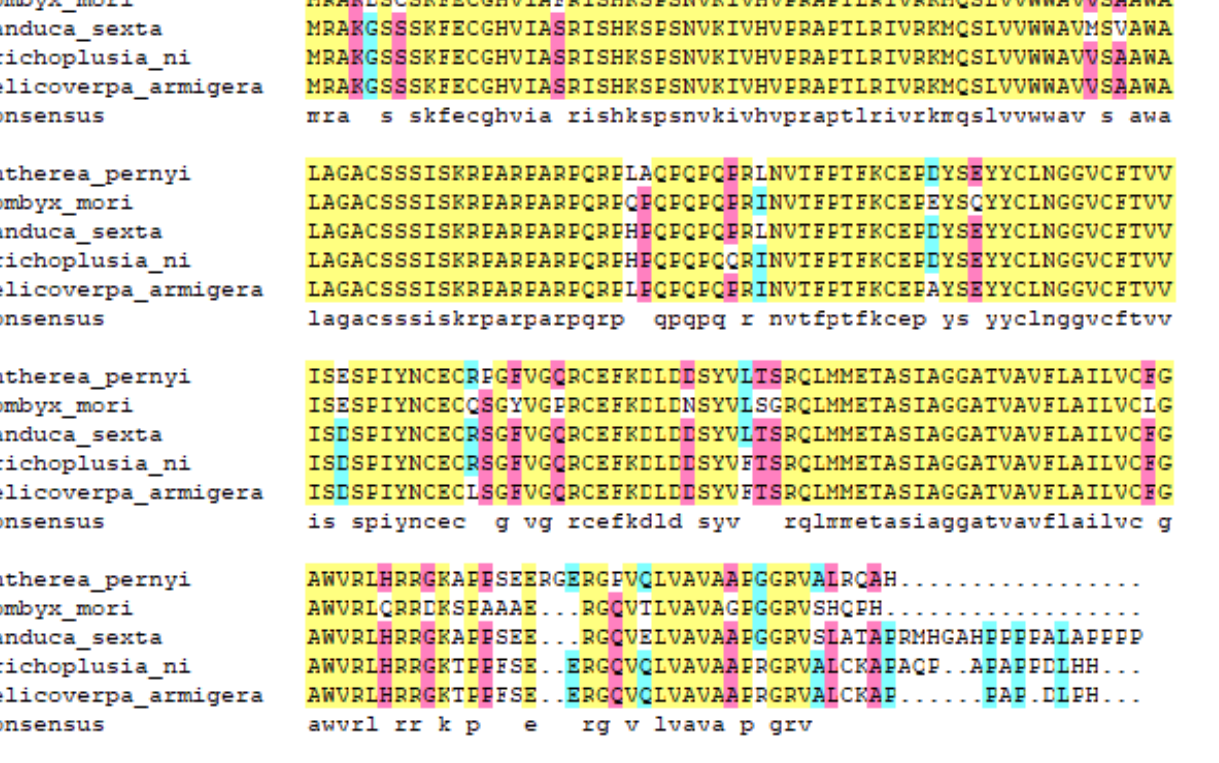
Figure 2. Alignment of amino acid sequences coded by ApEGF and other species. The sequences are as follows: Antheraea pernyi (OP407849), Bombyx mori (XP_004926209.1), Manduca sexta (XP_030025607.1), Trichoplusia ni (XP_026739166.1), and Helicoverpa armigera (XP_021192633.1).